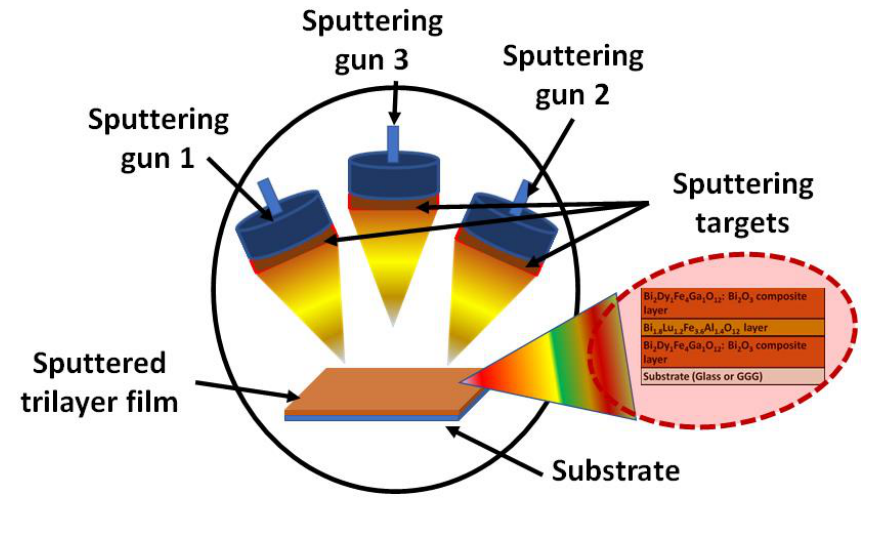
Figure 2. Schematic diagram of the sequential sputtering technique used to deposit the all-garnet multilayer structures.